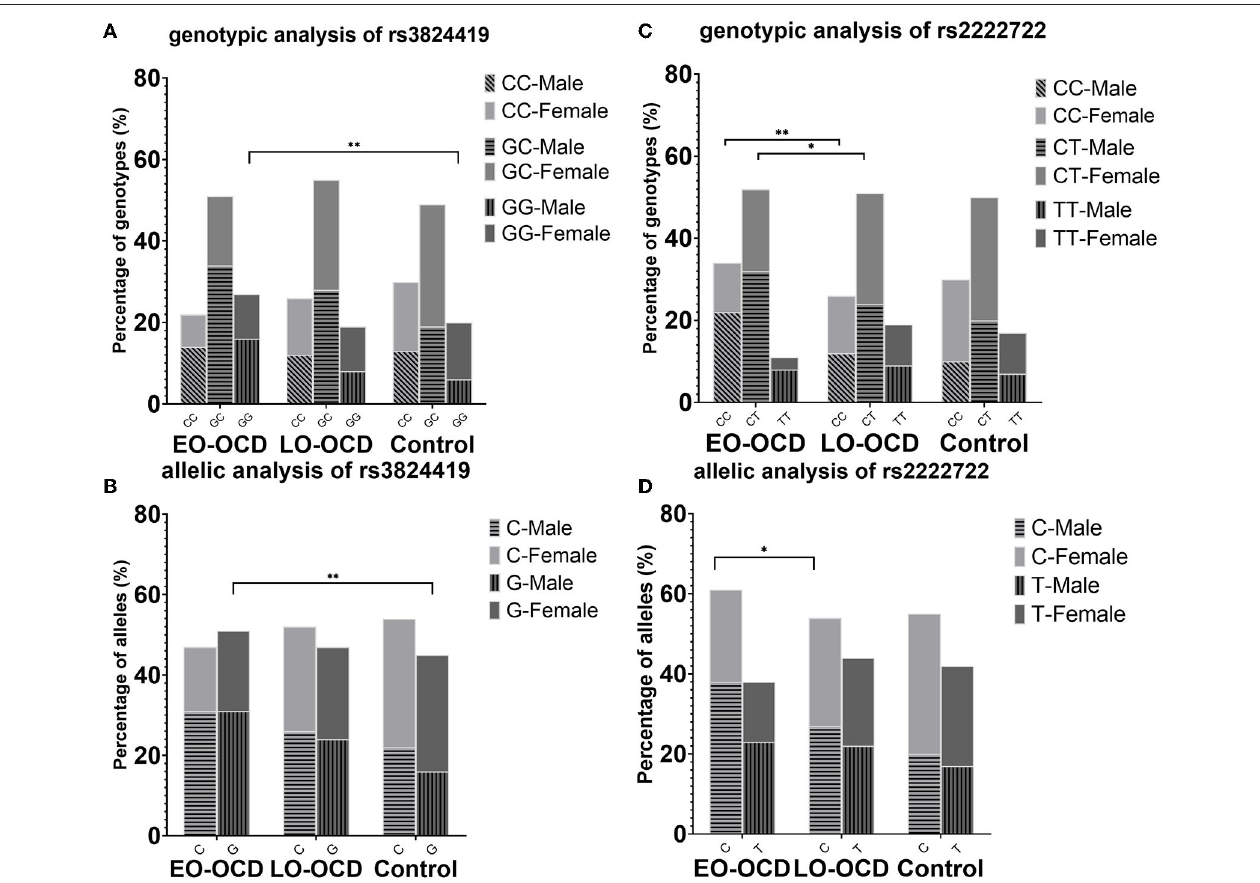
FIGURE 2 | Genotype and allele association results of rs3824419 and rs2222722, adjusted and separately presented by sex. (A) Genotype association results of rs3824419. Between EO-OCD and control, GG homozygotes showed significantly higher risk. (B) Allele association results of rs3824419. Between EO-OCD and control, allelic distribution was significant difference and G allele showed higher risk. (C) Genotype association results of rs2222722. Between EO-OCD and LO-OCD, both CC homozygotes and CC heterozygotes showed significantly higher risk. (D) Allele association results of rs2222722. Between EO-OCD and LO-OCD, allelic distribution was significant difference and C allele showed higher